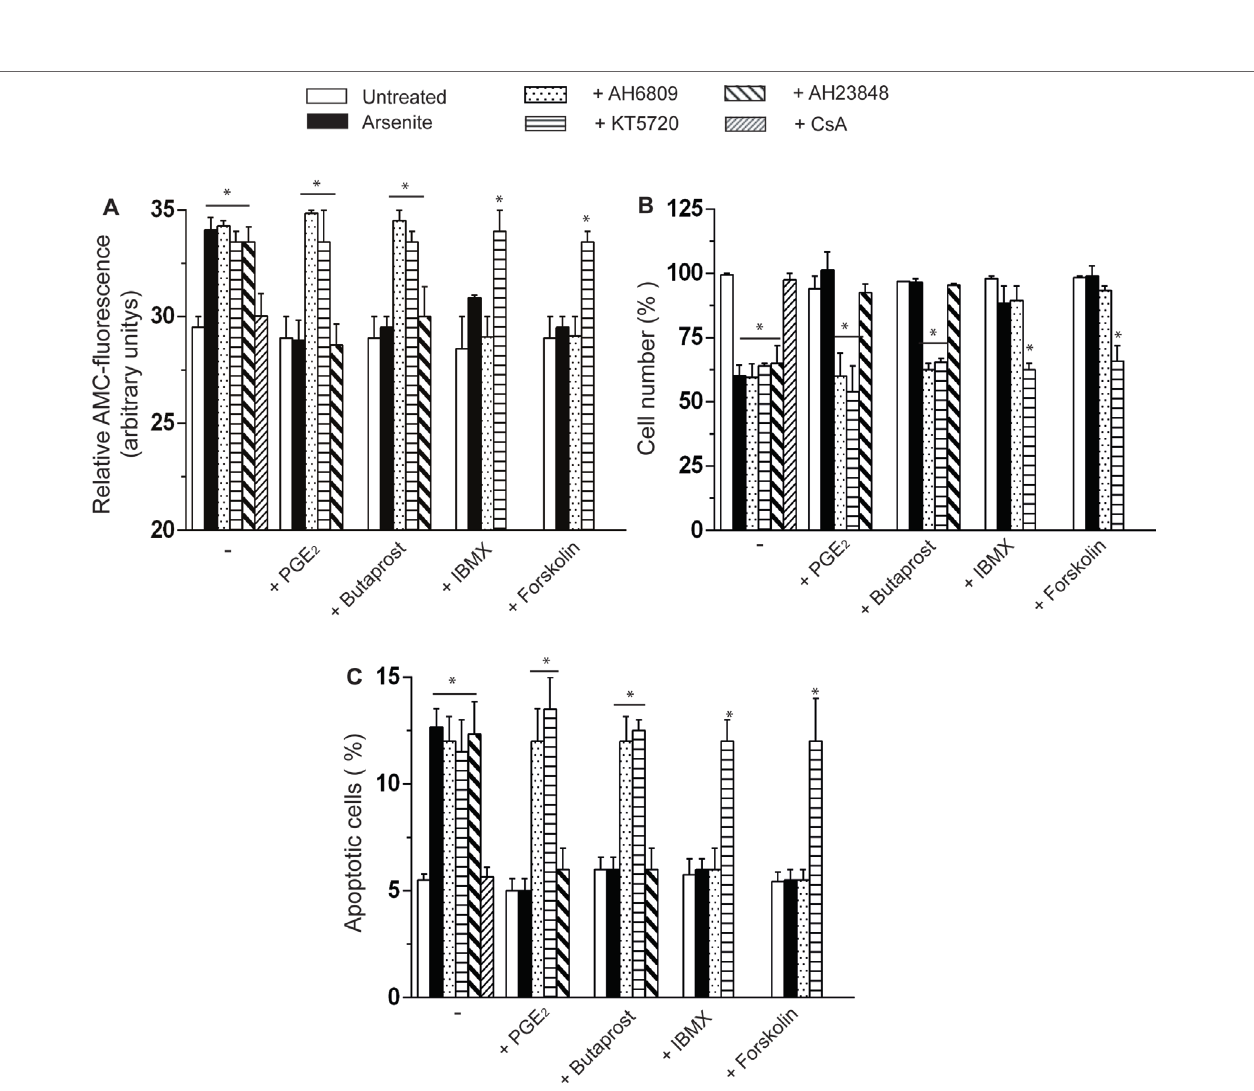
FIGURE 2 | PGE 2 prevents the apoptotic response mediated by arsenite via a mechanism involving EP 2 -receptor stimulation and downstream activation of PKA. (A–C) Cells were treated as indicated in the figure and using the same conditions detailed in the legend to Figure 1C – E . After 48 h, the cells were processed for the assessment of caspase 3 activity (A) and toxicity by either quantifying the number of viable cells (B) or measuring the percentage of apoptotic cells, i.e., cells displaying chromatin fragmentation/condensation (C) . Results represent the means ± SD calculated from at least three separate experiments. * p < 0.01, as compared with untreated cells (one-way ANOVA followed by Dunnett’s